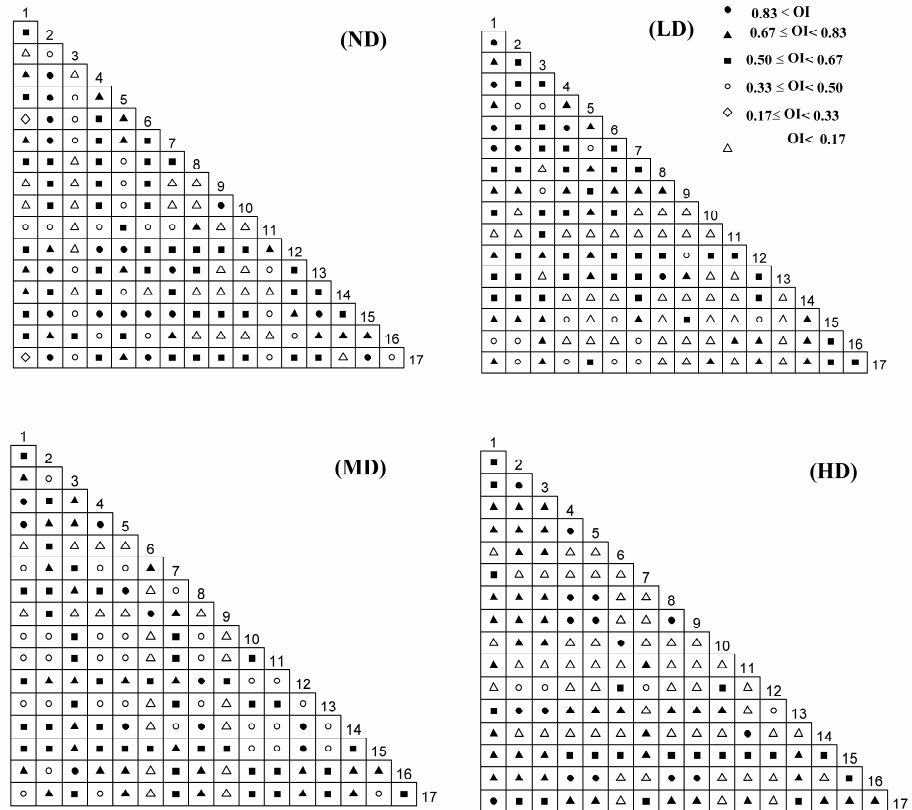
Figure 4. OI (Ochiai index) semi-exponential matrix of major species in different desertification stages in the Qinghai Lake Basin. ND stands for not desertification, LD for light desertification, MD for moderate desertification, HD for heavy desertification. See Table 1 for the meanings of species numbers.